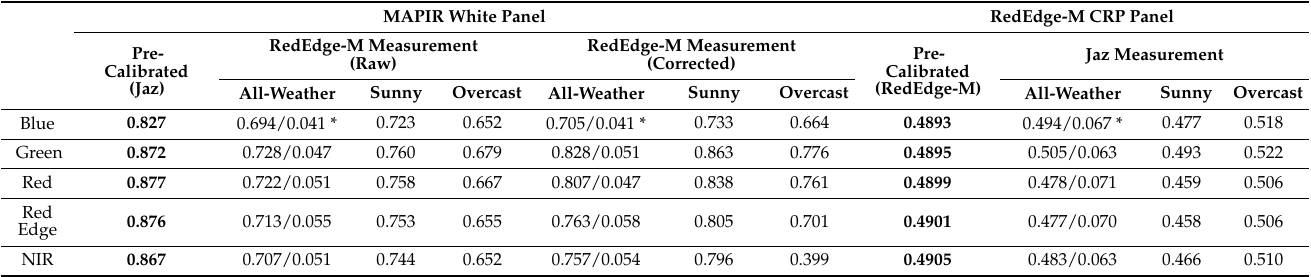
Table 4. Comparison of the pre-calibrated and field-measured reflectance of the MAPIR white and RedEdge-M CRP panels. For both panels, the pre-calibrated reflectance values are highlighted in bold. MAPIR White Panel RedEdge-M CRP Panel RedEdge-M Measurement RedEdge-M Measurement Pre- Jaz Measurement (Raw) (Corrected) Pre- Calibrated Calibrated (Jaz) (RedEdge-M) All-Weather Sunny Overcast All-Weather Sunny Overcast All-Weather Sunny Overcast Green 0.872